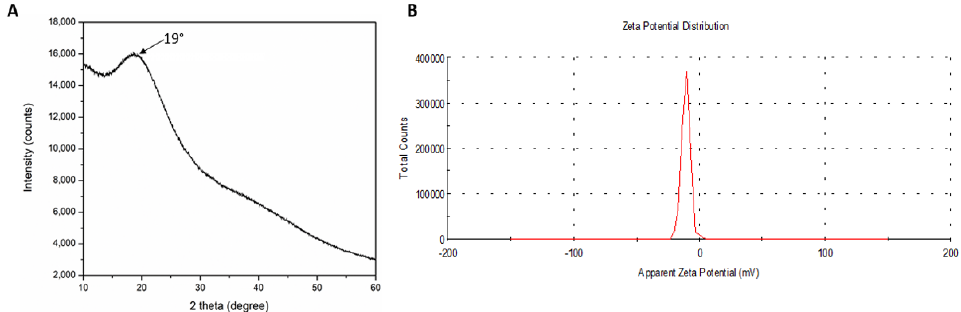
Figure 3. ( A ) XRD pattern of the prepared CDs. ( B ) Zeta potential of the CDs.